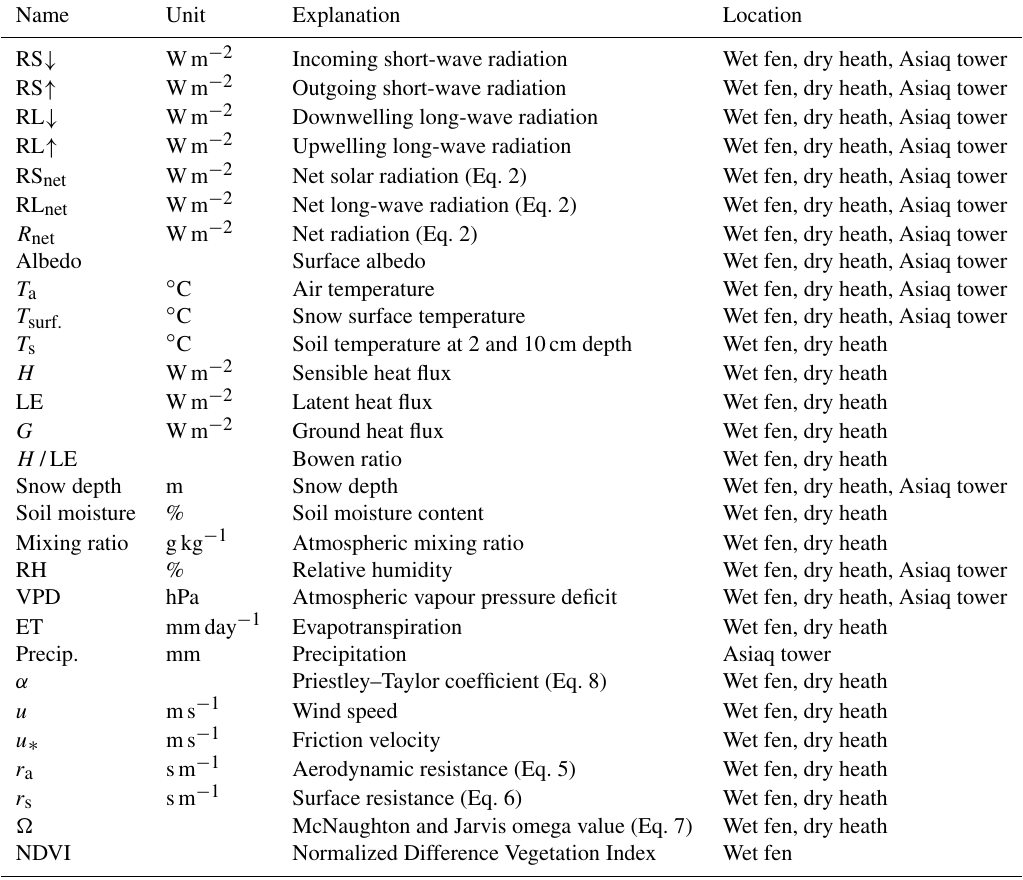
Table 1. List of parameters and symbols.